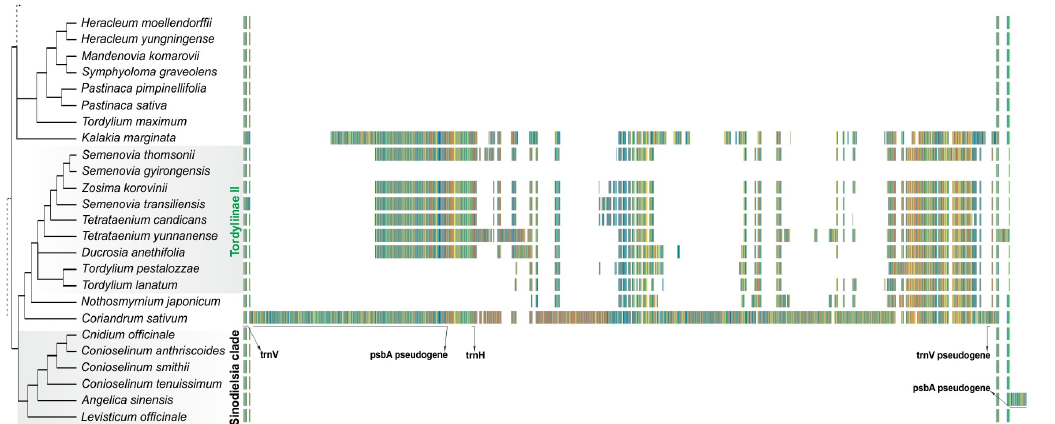
Figure 3. Spacer with an indication of trnV pseudogene, psbA pseudogene, trnH and trnV gene sequences, and the distribution of the insertions across the analyzed plastomes. Nucleotide bases in alignment are color-coded; a similar color pattern means a similar sequence. The positions of Kalakia and Ducrosia are shown as unresolved. Reassembled in this study, the plastomes of Semenovia thomsonii and Angelica sinensis are presented. Note no matching insertion site in Angelica .